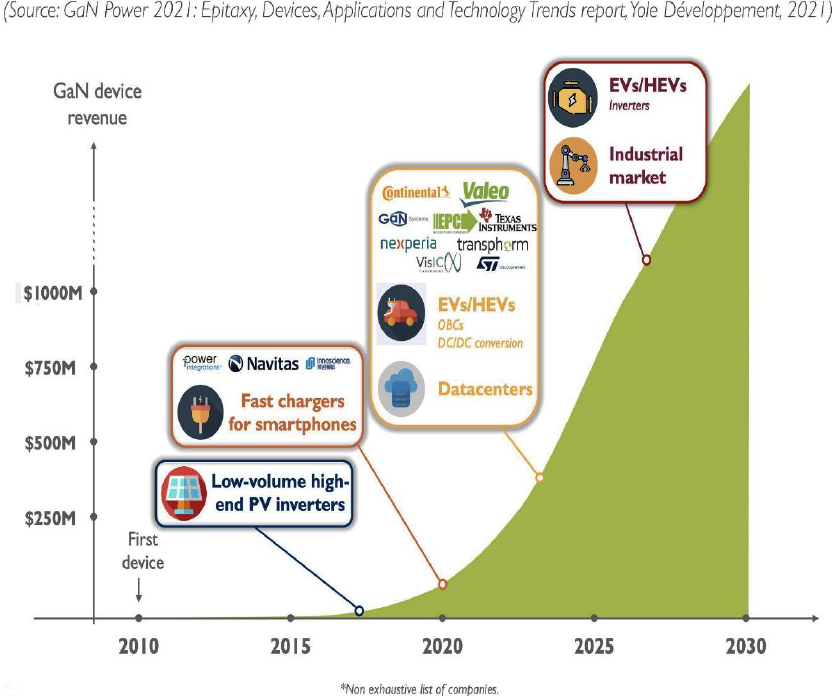
Figure 5. Roadmap for GaN power devices prediction by Yole. Reproduced with permission [4]. Copyright 2021, published by Yole Développement.